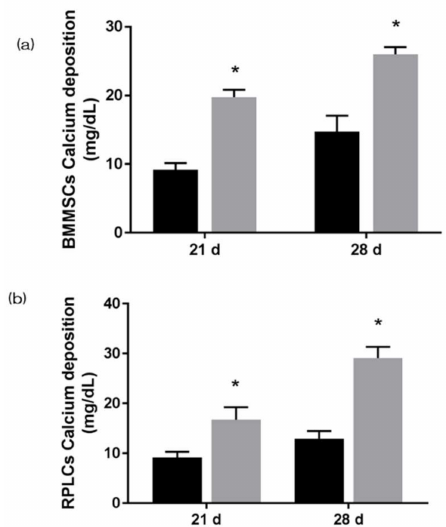
Figure 8. Mineralization was assayed for calcification, which is a late reaction of induction of hard tissue di ff erentiation. The amount of calcium deposited 21 and 28 days after the incubation of culture was significantly high on the material surface of the test group. (Gray bar—untreated surface, black bar—UV treated surface). (*: p < 0.05) ( a ) BMMSCs; ( b ) RPLCs.